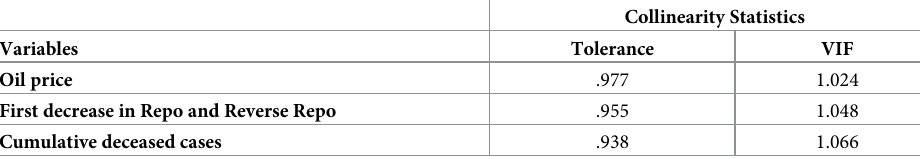
Table 3. Variable inflation factor analysis with Trading Volume as a dependent variable after dropping highest VIF.